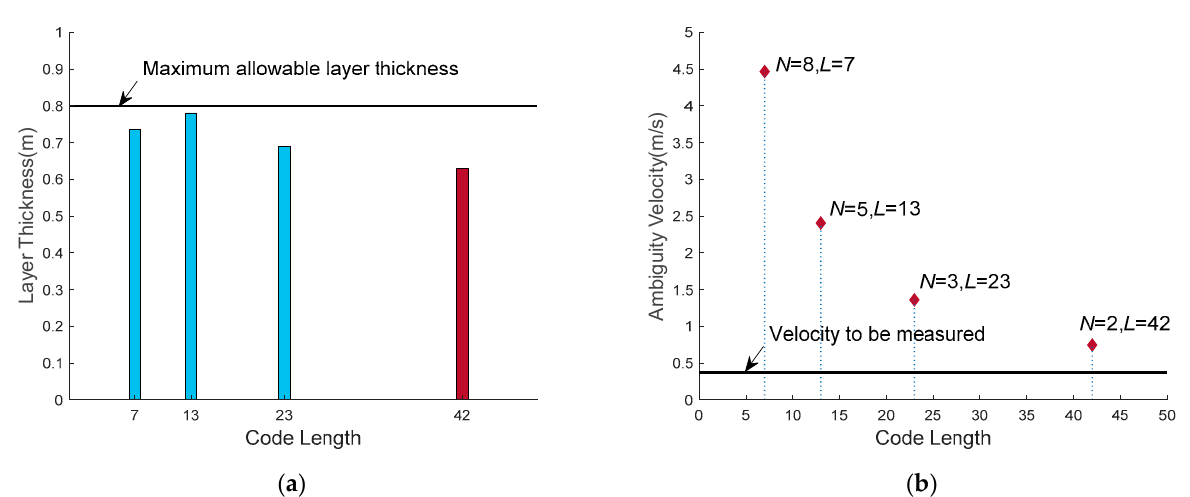
Figure 8. The layer thickness and velocity estimation range of the four waveforms all meet the constraint conditions: ( a ) layer thickness achieved by four waveforms; ( b ) velocity estimation range achieved by four waveforms.